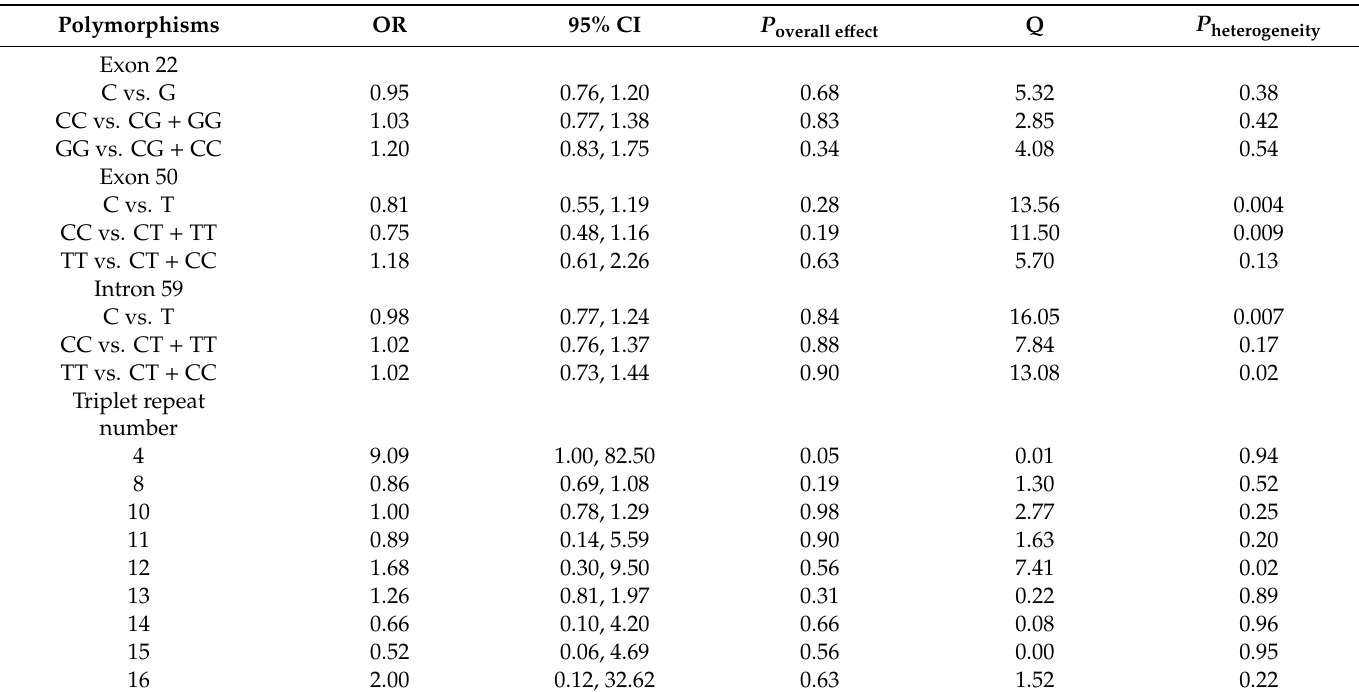
Table 5. Comparison of the allele and genotype frequencies of genetic variants in patients with autistic spectrum disorder (cases) versus healthy controls under a random e ff ects